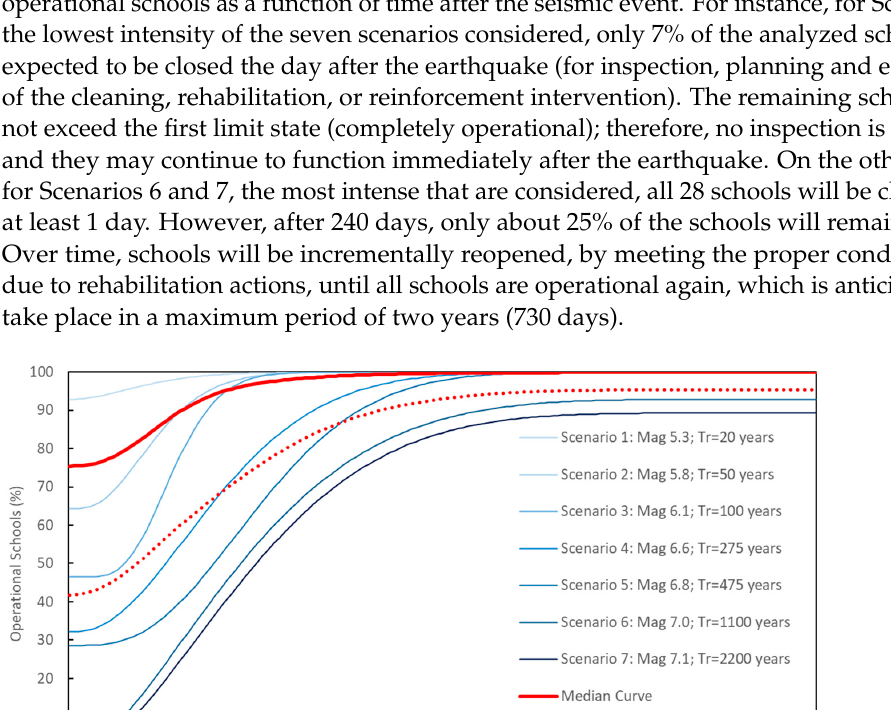
Figure 14. School ranking according to the number of interdiction days over 50 years.